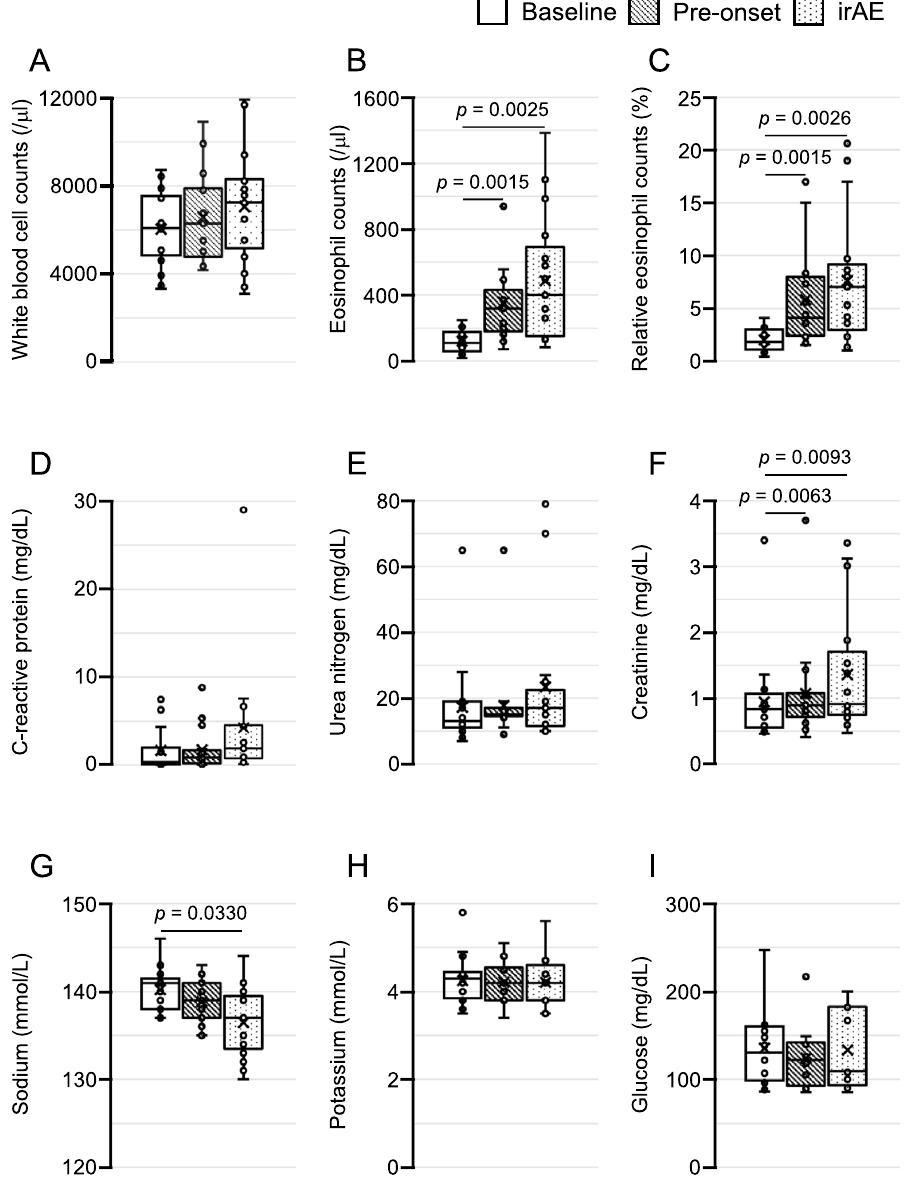
Figure 1. Longitudinal data in the AI group are shown by box plots. ( A ) White blood cell counts, ( B ) absolute eosinophil counts, ( C ) relative eosinophil counts, ( D ) C-reactive protein levels, ( E ) serum urea nitrogen levels, ( F ) serum creatinine levels, ( G ), serum sodium levels, ( H ) serum potassium levels, and ( I ) plasma glucose levels. ‘Baseline’ represents data before the first administration of ICIs. ‘Pre-onset’ represents data checked-up just before the patients experienced AI symptoms. ‘irAE’ represents data at the diagnosis of ICI-induced secondary AI. Statistical analyses were performed by Friedman’s test corrected by Bonferroni’s method. Significant differences of p < 0.05 were